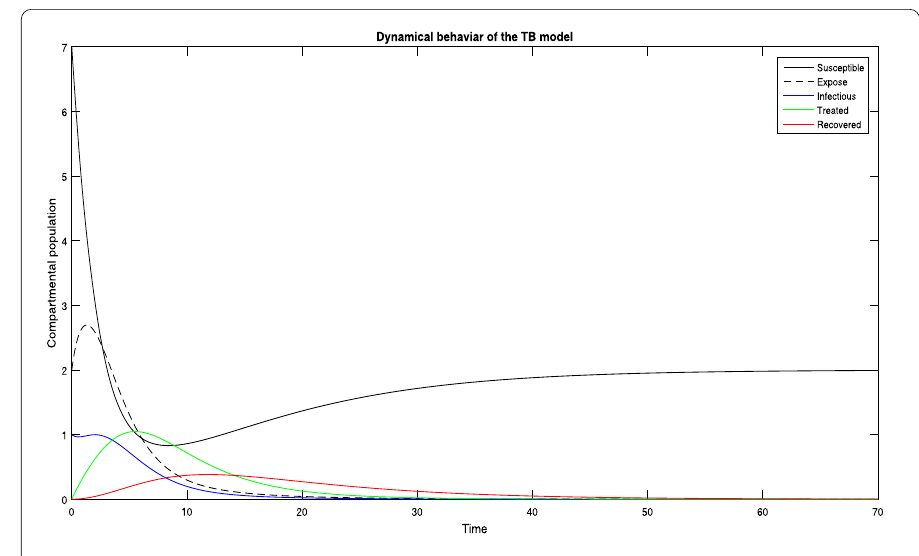
Figure 2 The plot shows the dynamics of all classes when (cid:2) 0 = 0.8484 < 1